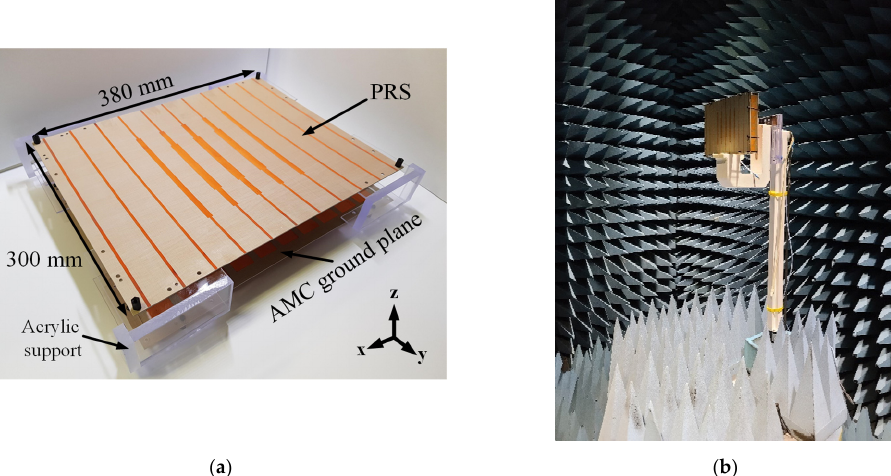
Figure 9. ( a ) The fabricated FPC antenna that consists of the PRS superstrate and the AMC ground plane with four acrylic supports and ( b ) its measurement environment.